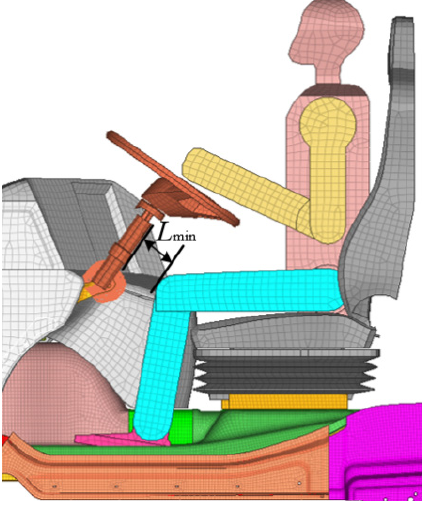
Figure 12. Schematic diagram of the characteristic dimensions.